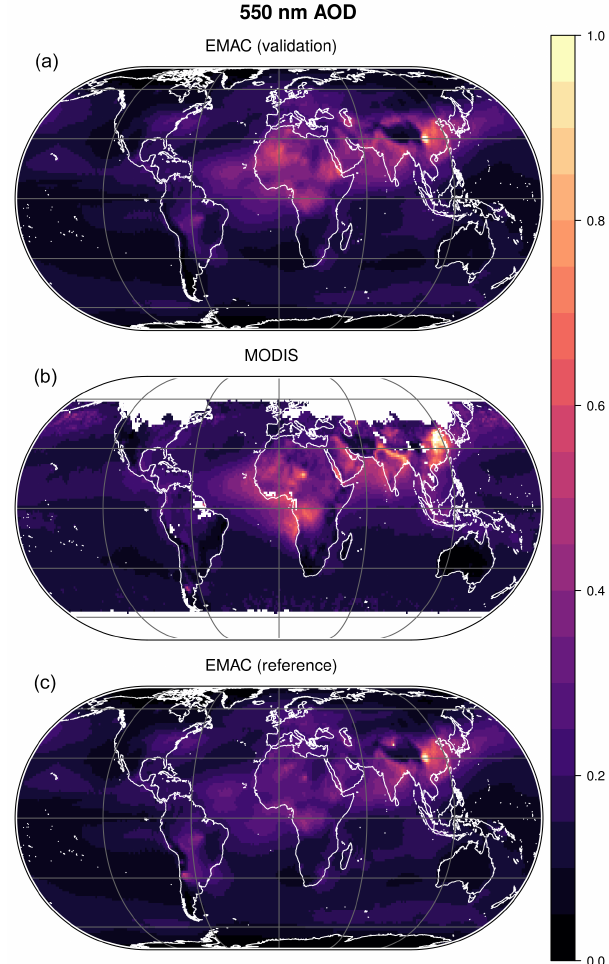
Figure 11. Annual mean for 2011 of the AOD at 550nm wavelength observed by MODIS (b) and simulated by EMAC with (“valida- tion”, a ) and without (“reference”, c ) revision of the dust emission scheme. The revised dust emissions enhance the correlation of the AOD pattern from 0.79 to 0.81 and the skill score from 0.58 to